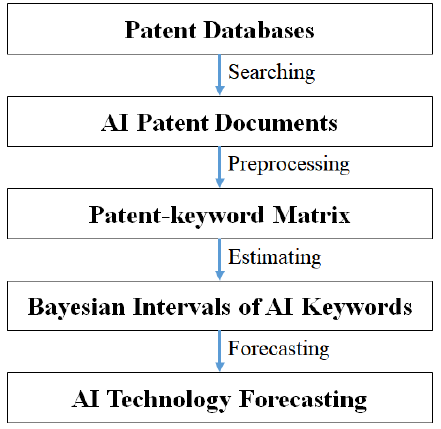
Figure 1. Proposed patent data analysis.